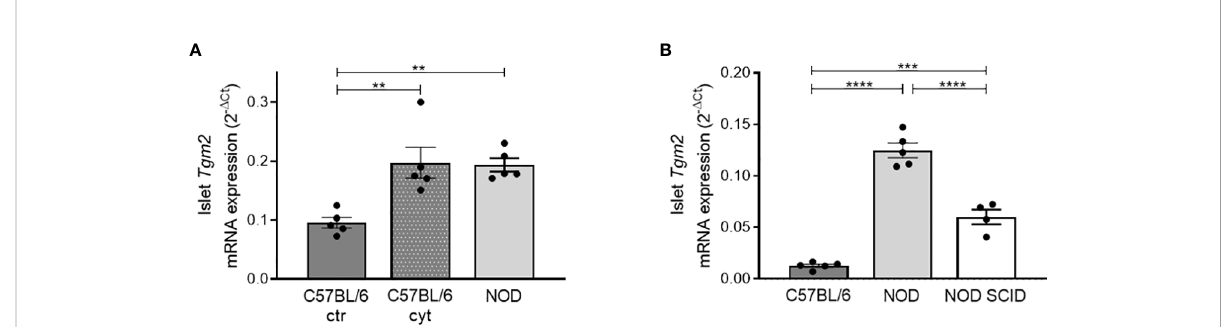
FIGURE 3 Increased Tgm2 levels in pancreatic islets are induced by cytokines. (A) Tgm2 mRNA in islets of Langerhans of 10-week-old C57BL/6 treated with or without in fl ammatory cytokines and NOD mice. (B) Tgm2 mRNA levels in islets of Langerhans of 10-week-old C57BL/6, NOD and NOD SCID mice. Data are shown as mean with SEM. One-way ANOVA with correction for multiple testing, **p<0.01, ***p<0.001 and